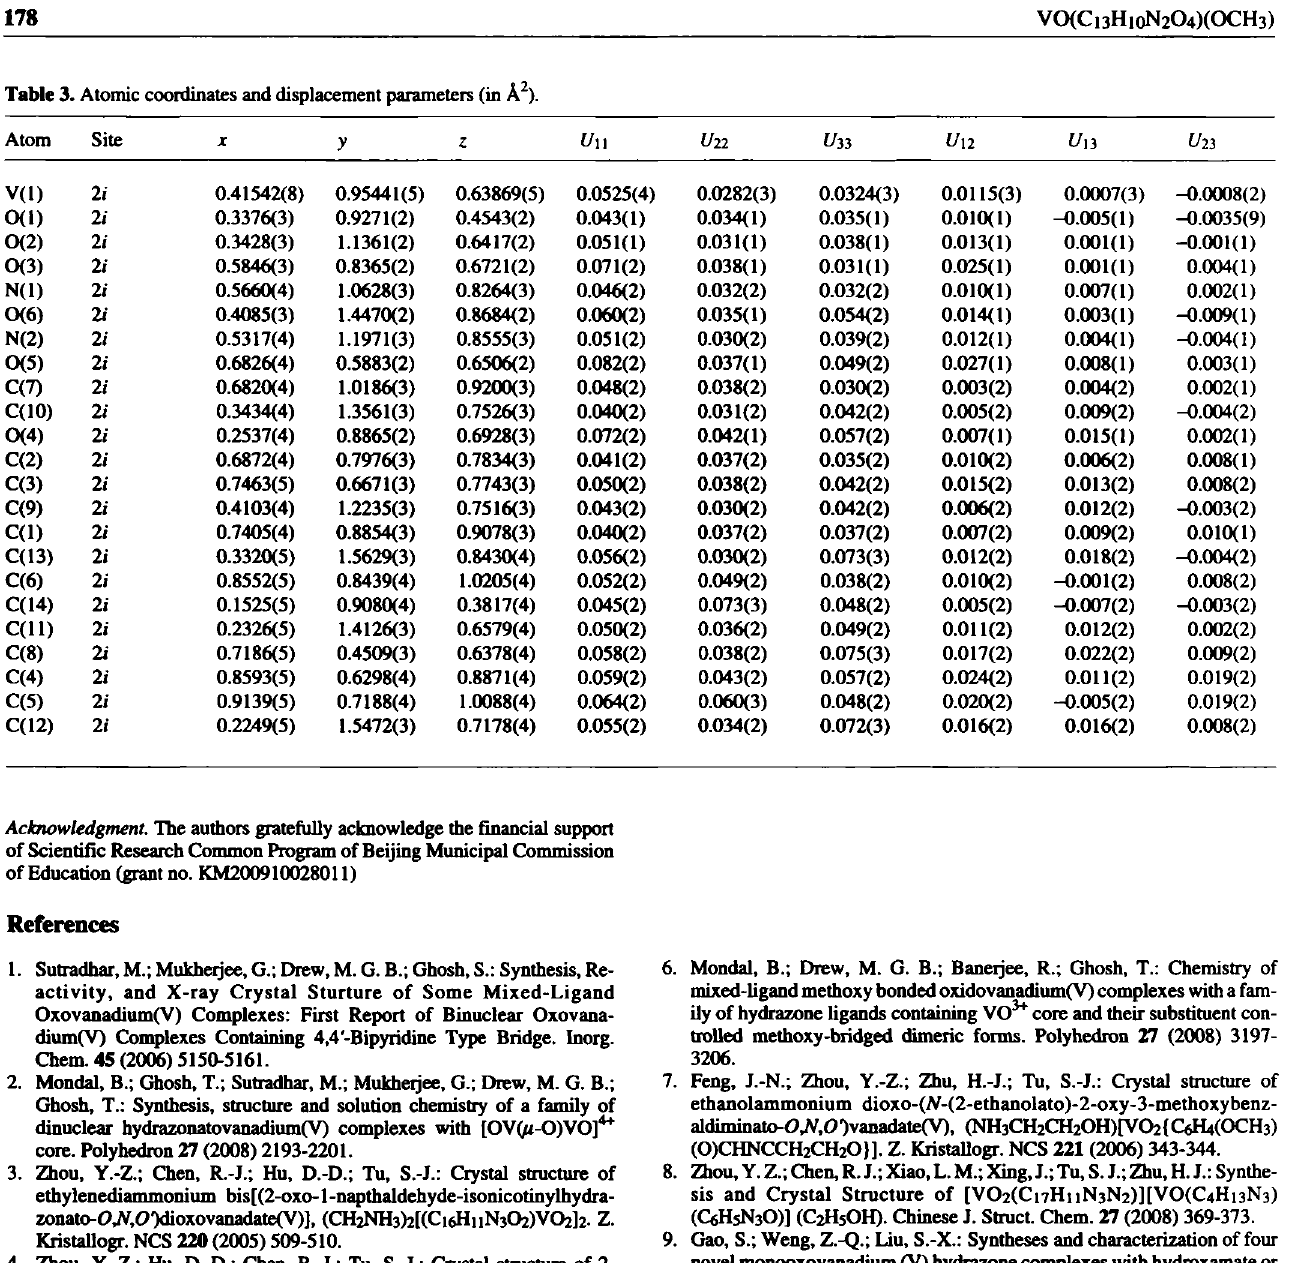
Table 3. Atomic coordinates and displacement parameters (in Â 2